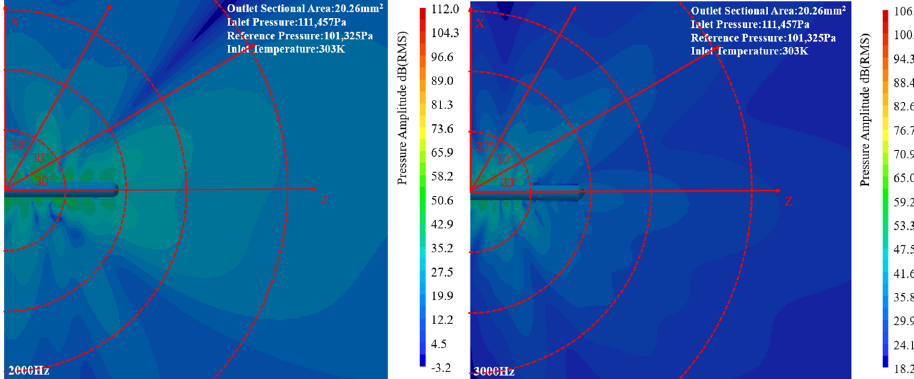
Figure 28. Nephograms of the 2000 Hz and 3000 Hz far-field sound pressure levels of standard